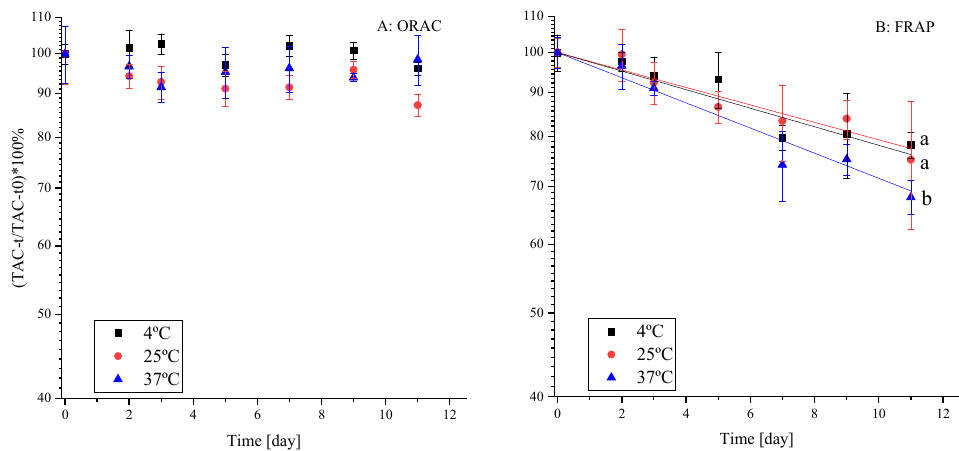
Figure 2. Relative TAC of strawberry polyphenols during shelf-life experiment at 4 °C, 25 °C and 37 °C, in a citric buffer (pH = 3, 50 mM), by ( A ) ORAC and ( B ) FRAP methods (presented as percentages). * Error bars represent standard error (n = 2), in ( B ) the line represents a fit to first-order kinetics. * Small letters by the regression line represent significant differences ( p < 0.05) as a function of temperature.